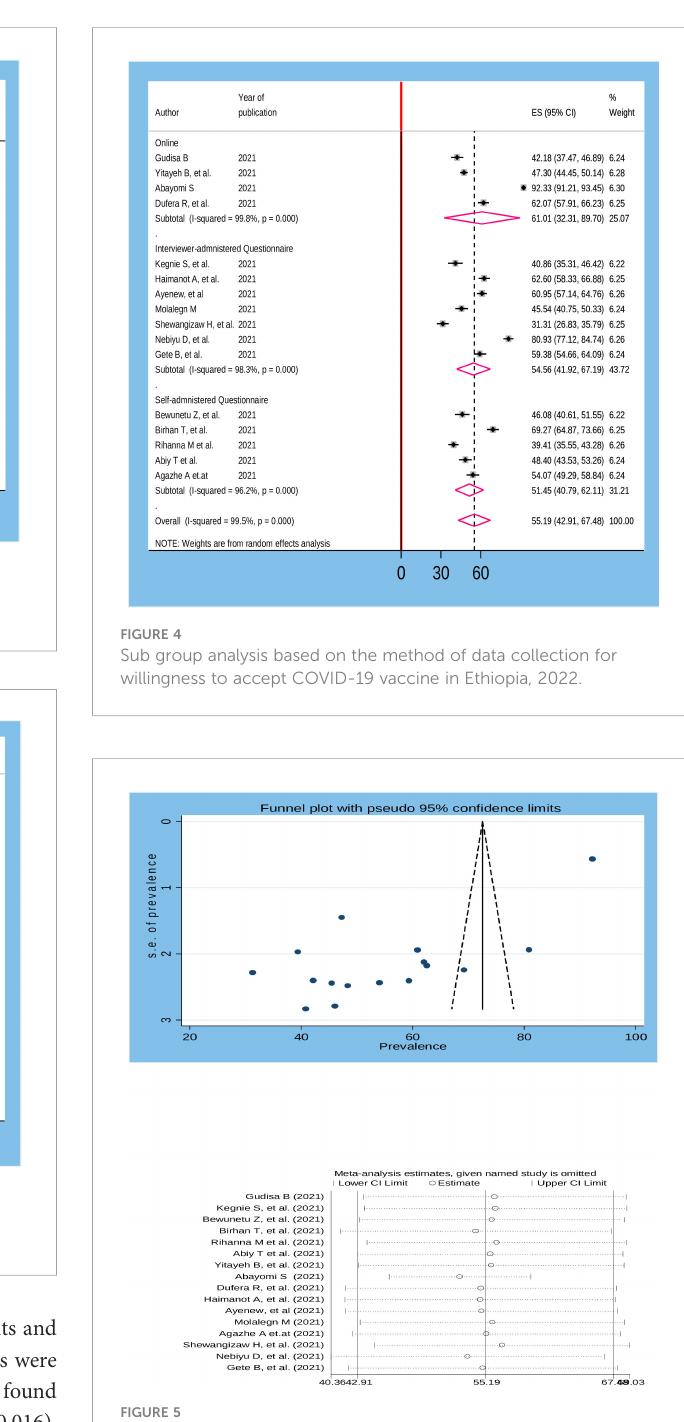
FIGURE 5 Funnel plot with 95% con fi dence limits of willingness to accept COVID-19 vaccine in Ethiopia,